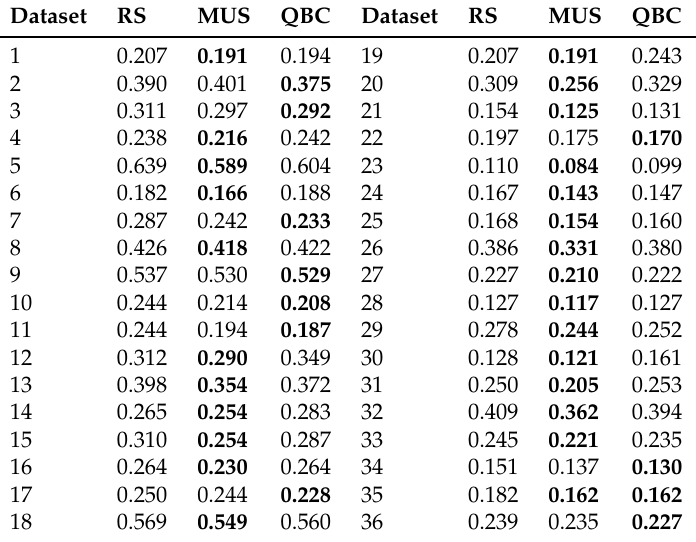
Table 5. Values of the average of E obtained in the 50th iteration of the algorithm for all strategies. The smallest value of E within query strategies is in bold.